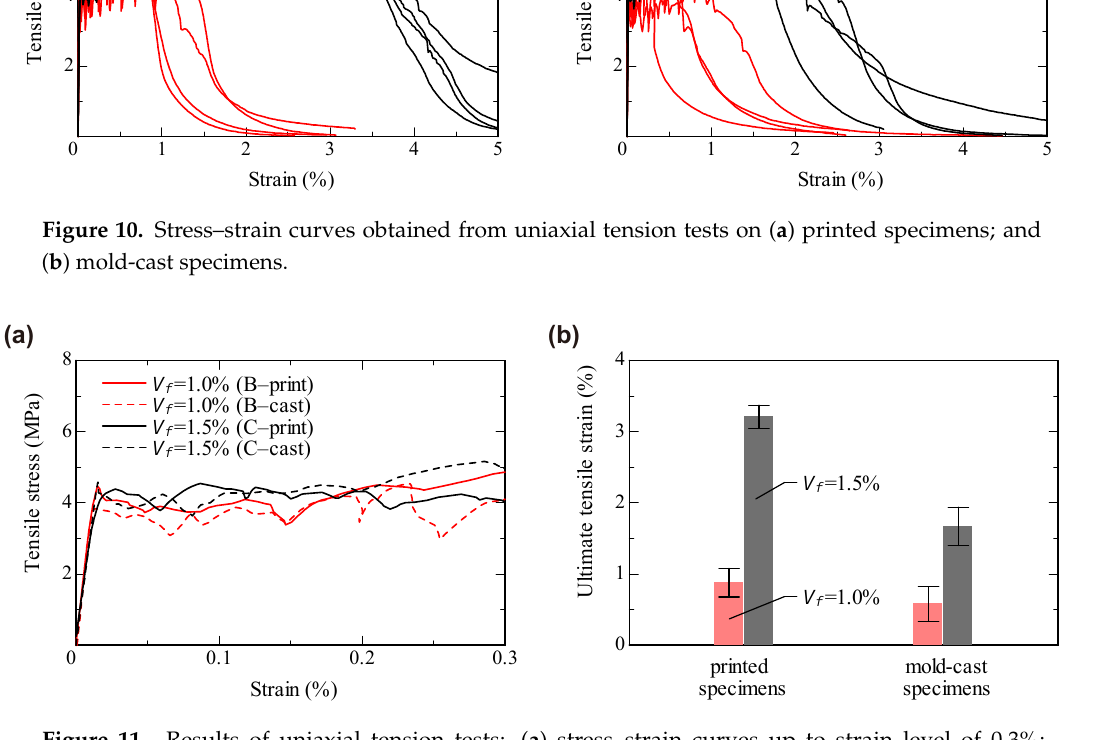
Figure 11. Results of uniaxial tension tests: ( a ) stress–strain curves up to strain level of 0.3%; and ( b ) ultimate tensile strain (strain